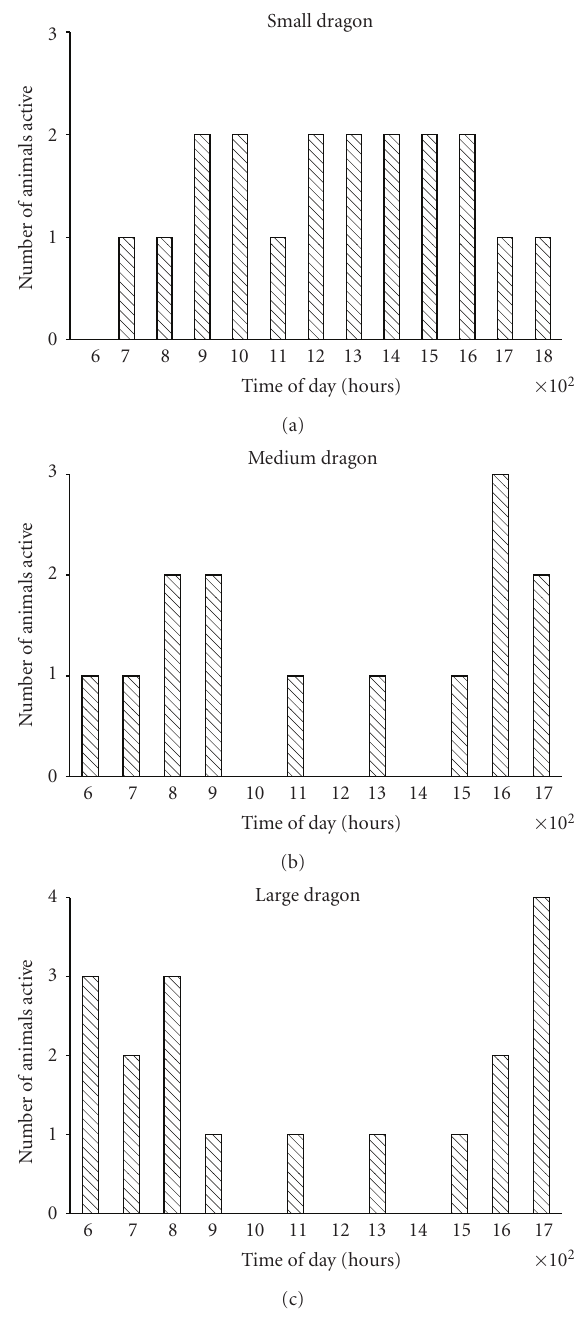
Figure 3: A representative hourly day-time census of small (a), medium (b), and large (c) dragons within the Loh Buaya ranger camp. Bars represent the number of animals within each size group that were observed active each hour between 0600 and 1700.